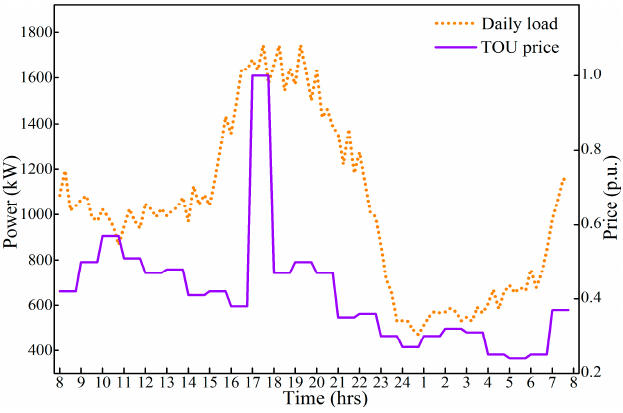
Figure 5. Data profile for simulation. Table 2. Parameters for the single electric vehicle (EV).